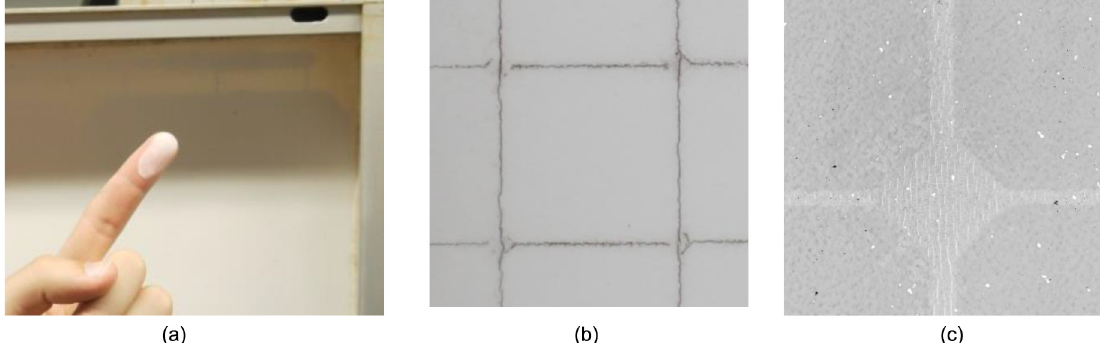
Fig. 3. Images from different degradation features; (a) Chalking on rear side of a polyamide backsheet [9]; (b) Cracked AAA backsheet; (c) Small cracks, indicating a damaged PP layer in a F-C/PET/PP backsheet.